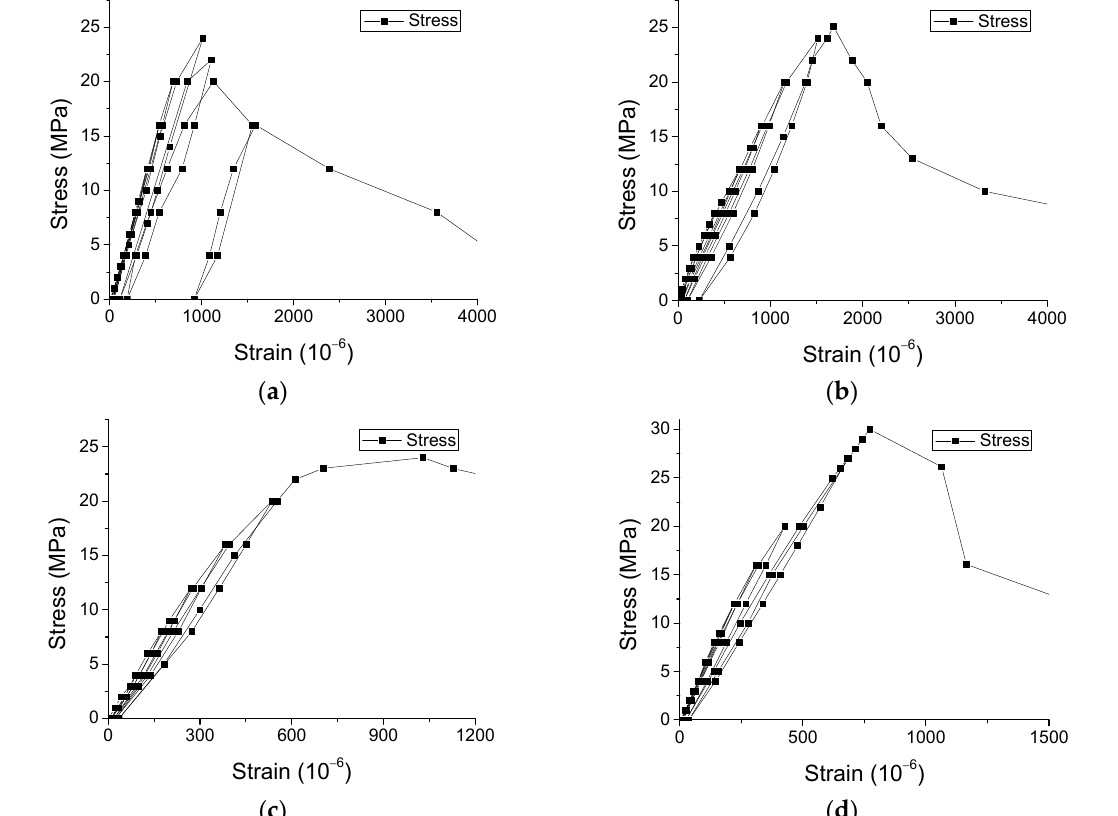
Figure 8. Typical experimental results of stress-strain curves for SCC prismatic specimens under cyclic compression. ( a ) Sample C-Prism 9, ( b ) Sample C-Prism 10, ( c ) Sample C-Prism 11, and ( d ) Sample C-Prism 12.